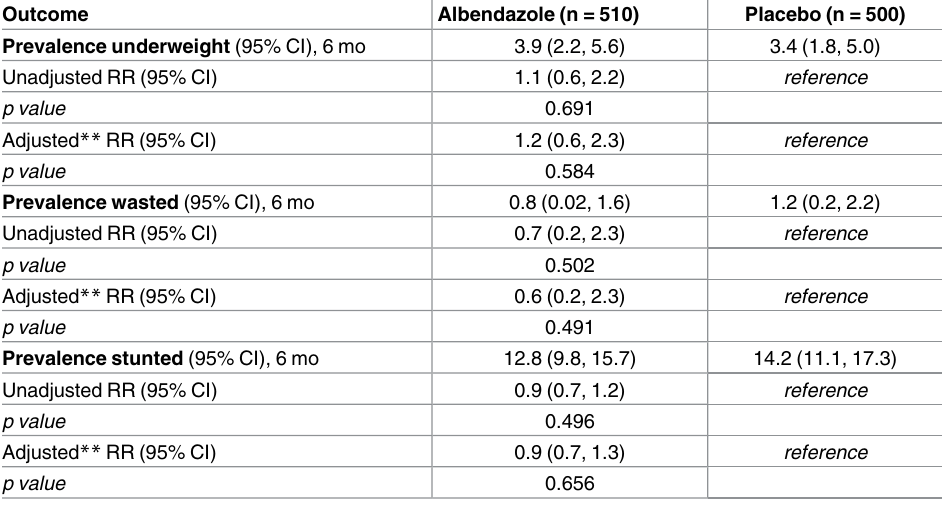
Table 4. Effect of maternal postpartum deworming on prevalenceof infant underweight, wasting, and stunting at 6 months of age (N = 1010 * ),Iquitos, Peru (August 2014–February 2015).